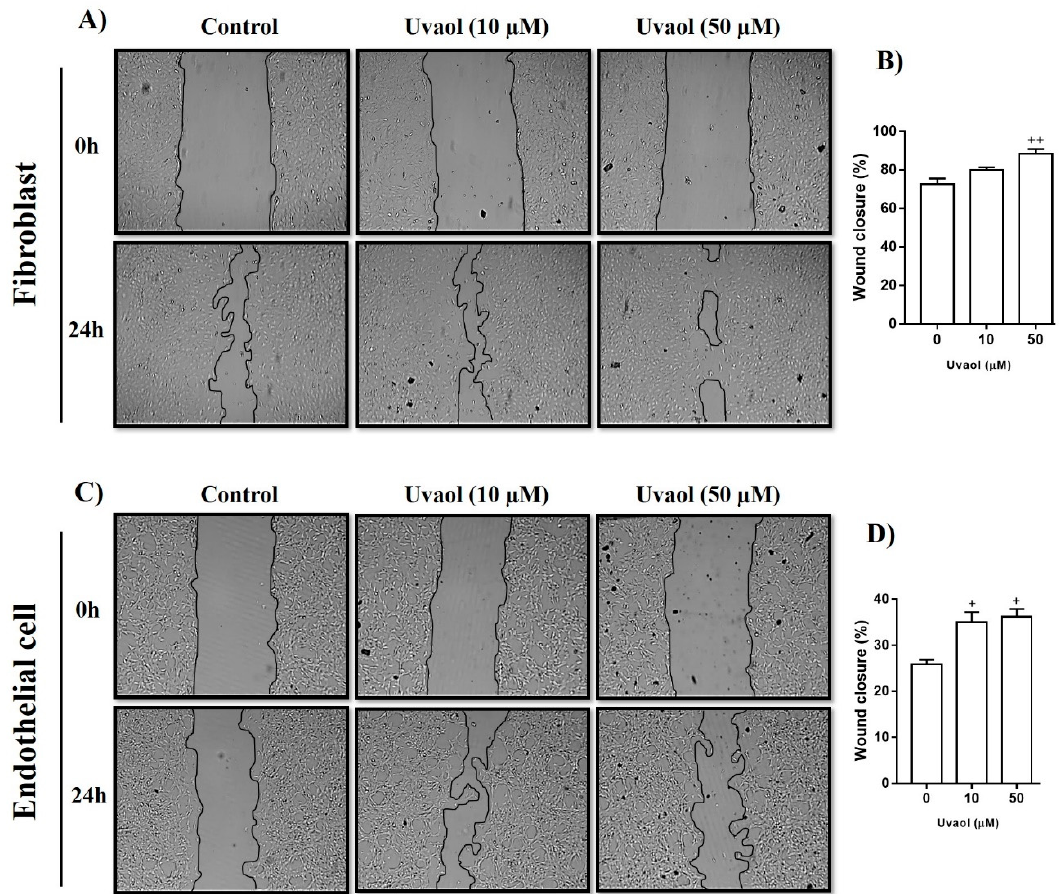
Figure 3. Effect of uvaol on the cell migration of fibroblasts and endothelial cells in the scratch assay. Cells were treated with 10 or 50 µM uvaol, and images were captured to calculate the scratch closure. Representative photomicrography images showing the scratched area of fibroblasts ( A ) and endothelial cells ( B ) treated with medium (control) or uvaol, and cell migration towards the cell-free area after 24 h (magnification 40×). The percentage of the scratch covered was measured by quantifying the total distance that cells moved from the edge of the scratch towards the center of the scratch, using ImageJ software, followed by conversion to a percentage of the wound that was covered ( C , D ). Values represent mean ± SD from three independent experiments. (+) p < 0.05 and (++) p < 0.01 compared with medium-treated cells after 24 h.